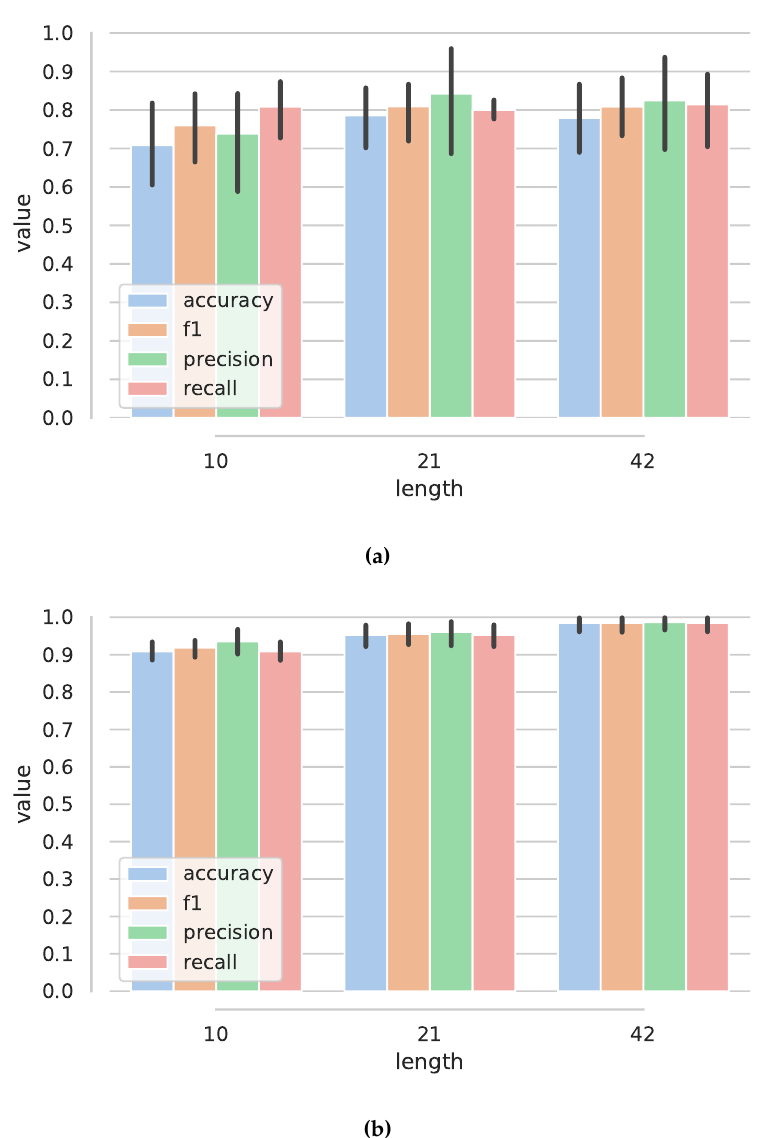
Figure A2. Results for learning on a single user’s data and classifying the same user’s data. ( a ) Bar plots for anomaly classification for a single user, length is N s = 42. ( b ) Bar plots for exercise classification for a single user, length is N s =